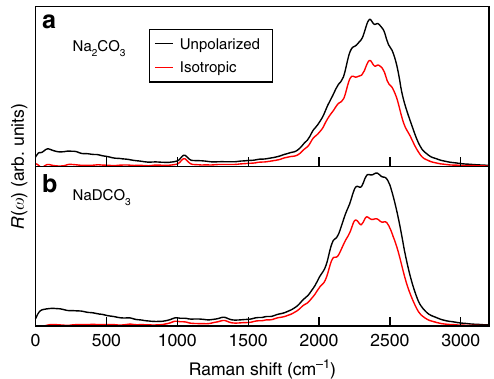
Fig. 2 Raman spectra of 0.9 mol L − 1 solutions at ambient density and 380 K. Calculated unpolarized (black line) and isotropic (red line) spectra of the sodium carbonate and deuterated sodium bicarbonate solutions are shown in the upper and lower panels, respectively.